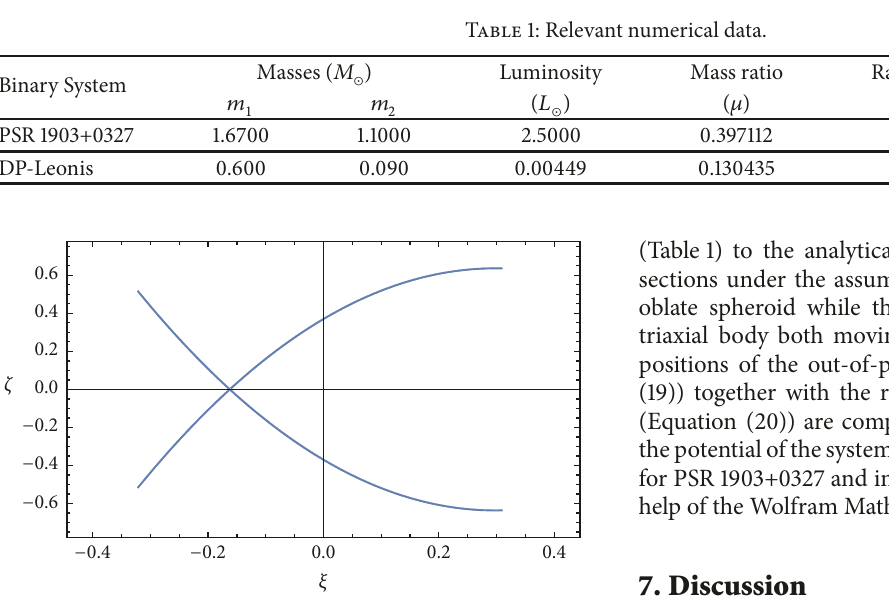
Figure 12: Positions of 𝐿 6,7 in the ( 𝜉 − 𝜁 ) plane as a function of triaxiality 𝜎 1 and 𝜎 2 in the interval [0.01, 0.02] and [0.005, 0.01] , respectively, of PSR 1903+0327 for 𝑎 = 0.95, 𝐴 = 0.1.